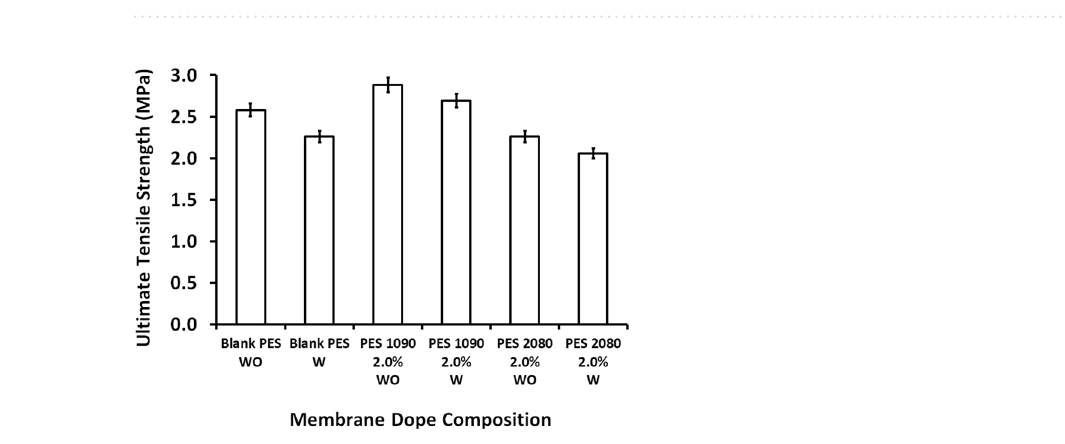
Figure 12. TEM elemental mapping of PES 2080 2.0% W magnetic mixed matrix membrane.